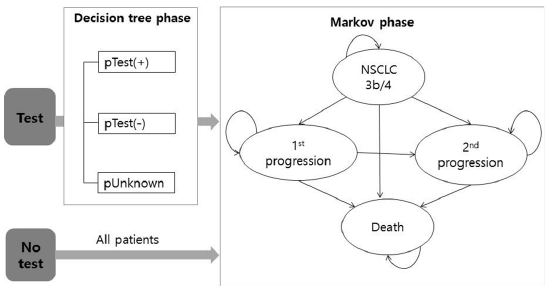
Fig 1. Model structure. NSCLC, non-small cell lung cancer; pTest+, proportion of test positives; pTest-, proportion of test negatives; pUnknown, proportion of unknown tests. Note: pTest+ = pTP + pFP [pTP = prevalence × sensitivity × (1-pUnknown), pFP = (1-prevalence) × (1-specificity) × (1-pUnknown)]; Test- = pTN + pFN [pTN = (1-prevalence) × specificity × (1-pUnknown), pFN = prevalence × (1-sensitivity) × (1-pUnknown)]. ※ pTP, pFP, pTN, and pFN is the proportion of true positive, false positive, true negative, and false positive results, respectively. Prevalence is the percentage of patients harboring EGFR mutations in stage 3b and 4 lung